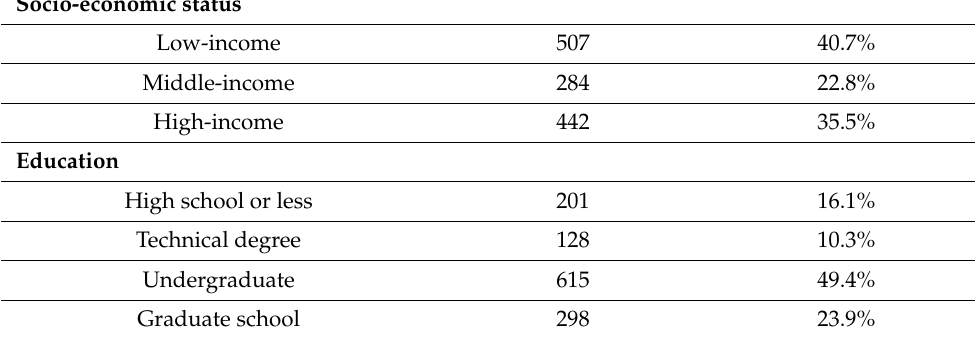
Table 1. Cont. Socio-economic